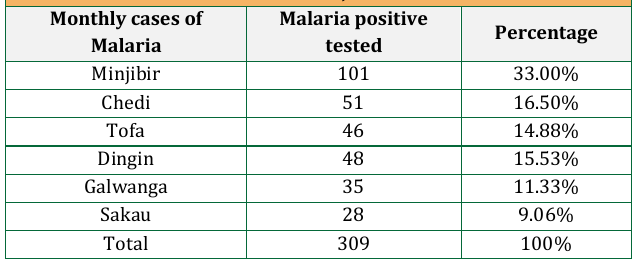
Figure 4: One-way ANOVA at 0.05 significant levels in 2017 MSE =0 and the degree of freedom for error =0